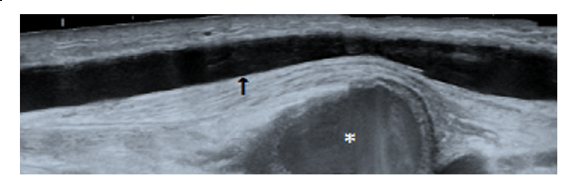
Fig. 2 B-Mode ultrasound image of the cephalic vein in the longitudinal plane (black arrow). The pseudoaneurysm (*) is demonstrated lying deep to the cephalic vein, directly in line with the needling